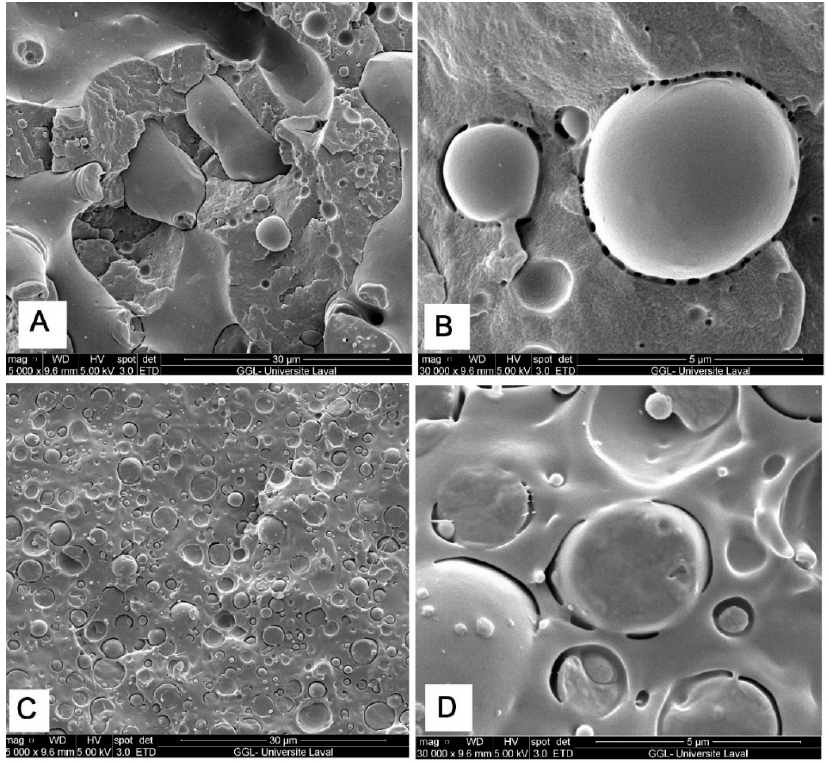
Figure 3. SEM micrographs of PA20/(PBAT20) ( A , B ) and PA20/(PEO20) ( C , D ) ternary blends (see Section 3.2 for definition). Section 3.2 for